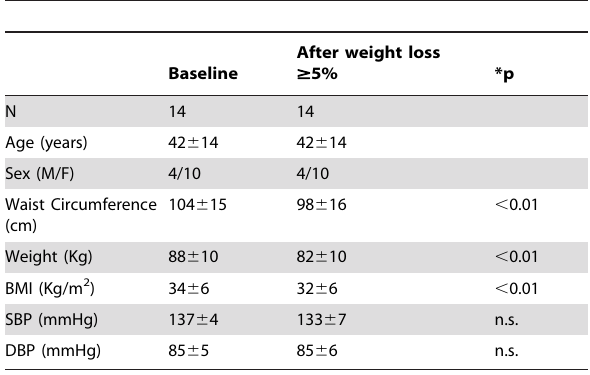
Table 1. Clinical and anthropometric parameters of study